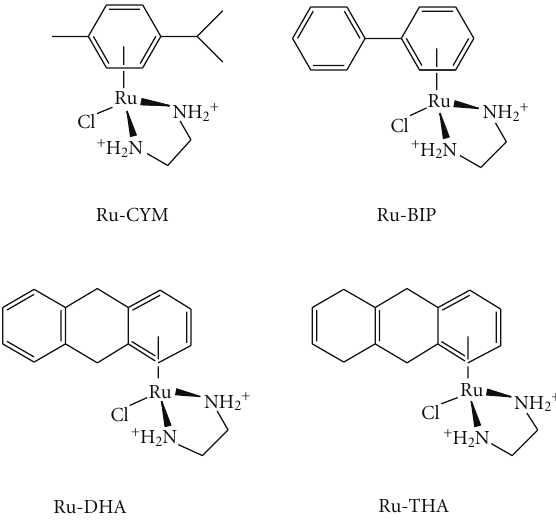
Figure 4: Ruthenium derivatives. Ru-CYM , Ru-BIP , Ru-DHA, and Ru-THA are examples of ruthenium-containing agents inducing local destabilization of the DNA helix.